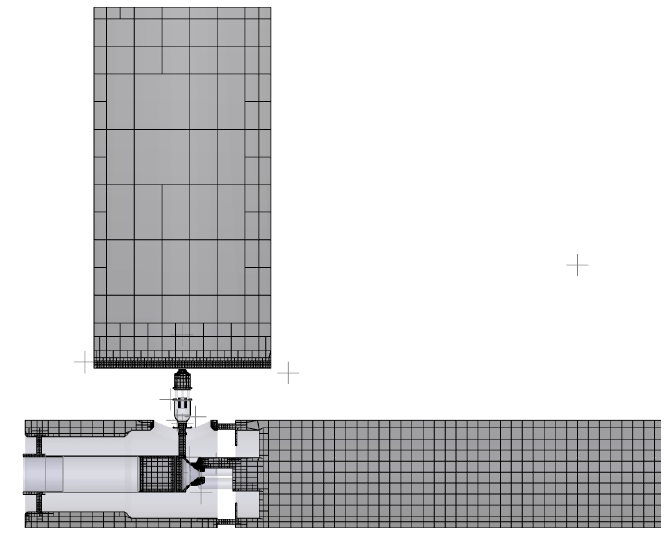
Figure 17. PumpLinx simulation physical model.